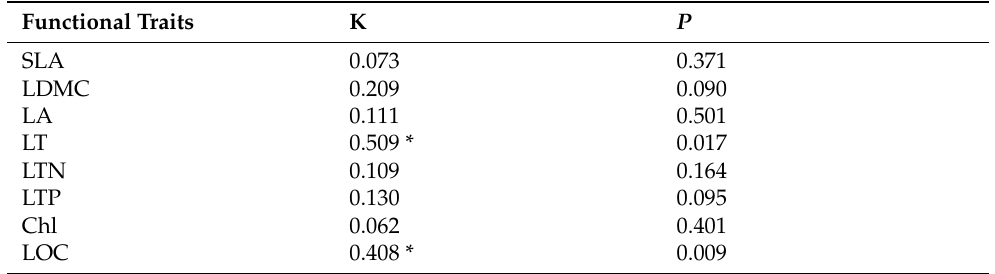
Table 2. Phylogenetic signal of functional traits of dominant species in the study plots in Dianchi lakeside. Functional Traits K P SLA 0.073 0.371